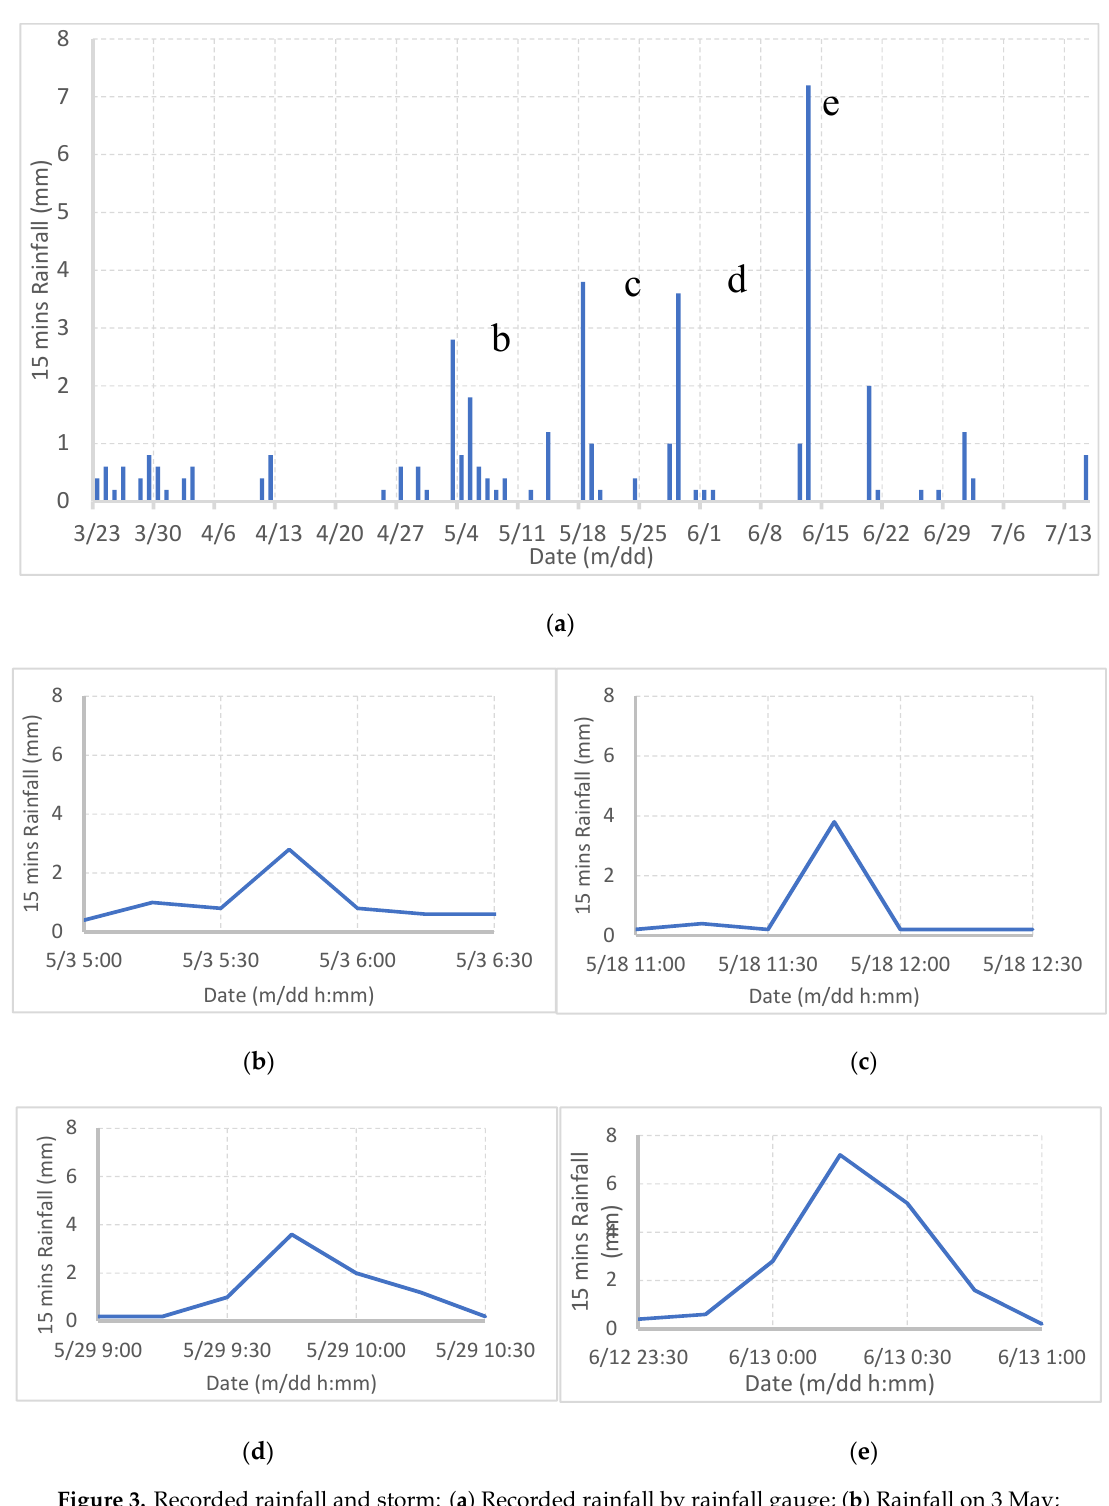
Figure 3. Recorded rainfall and storm: ( a ) Recorded rainfall by rainfall gauge; ( b ) Rainfall on 3 May; ( c ) Rainfall on 18 May; ( d ) Rainfall on 29 May; ( e ) Rainfall on 13 June. Distributed temperature sensing generates a series of two-dimensional data sets (temperature against distance). The temperature is measured every 2 m for the entire length of the sensor (1170 m) and measurements are taken every two minutes. A waterfall plot shows how this two-dimensional the sewer at the time and location they occur. Figure 4 plots DTS monitoring results under normal conditions without rain. X-axis is the distance, y-axis is time. Different colour means different